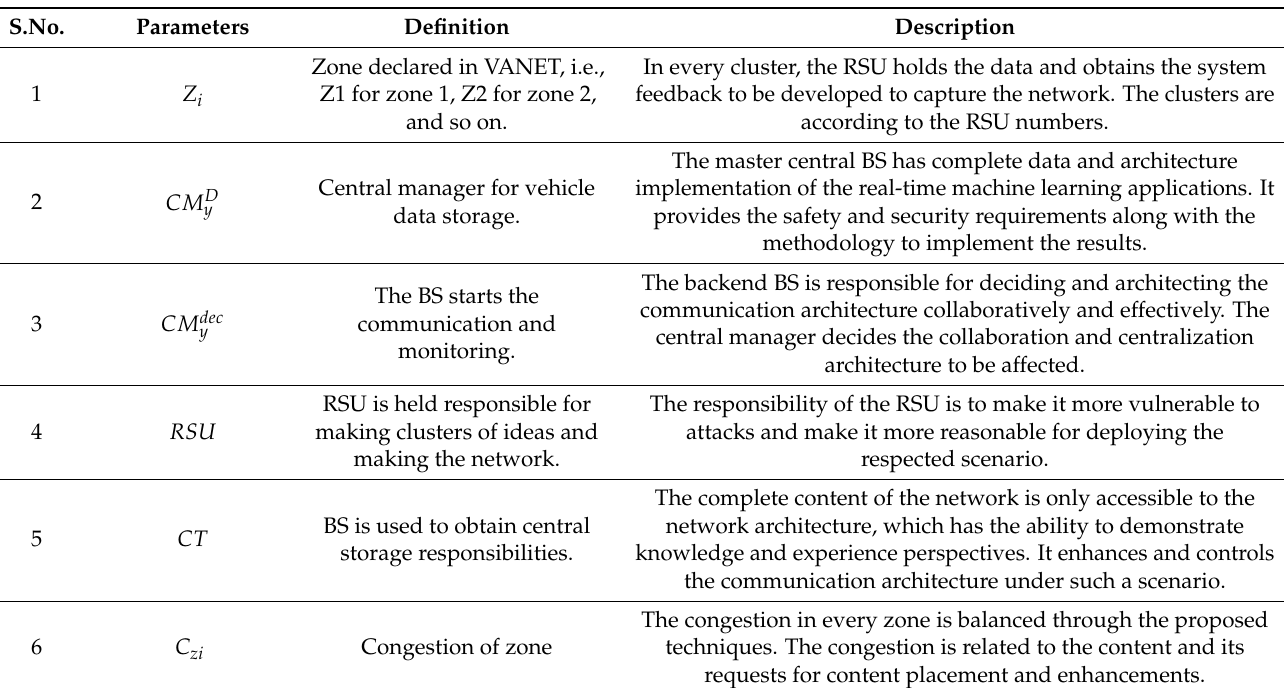
Table 2. Parameters with the descriptions used for the proposed